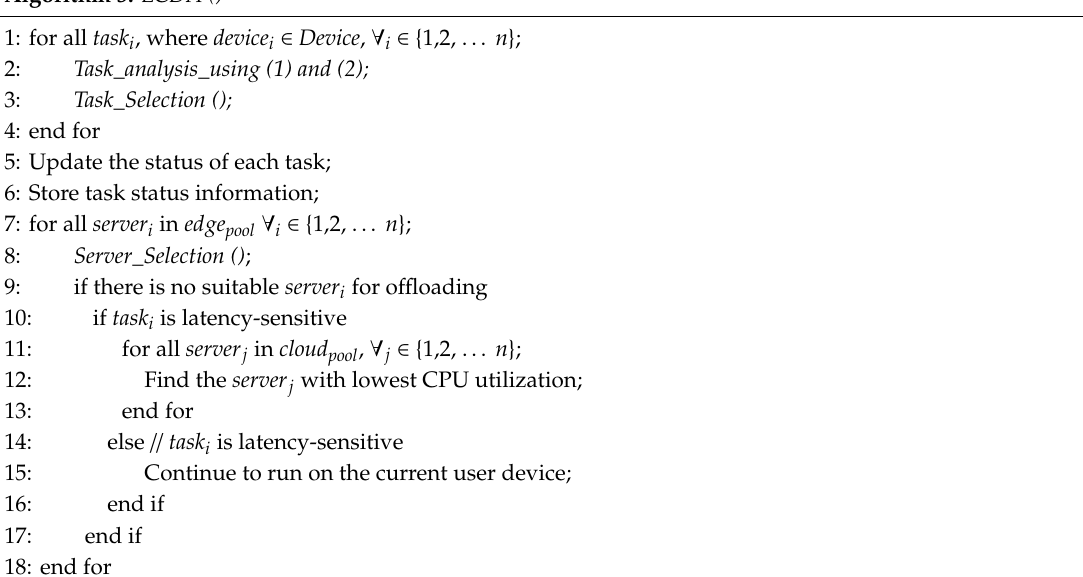
Algorithm 3. LCDA